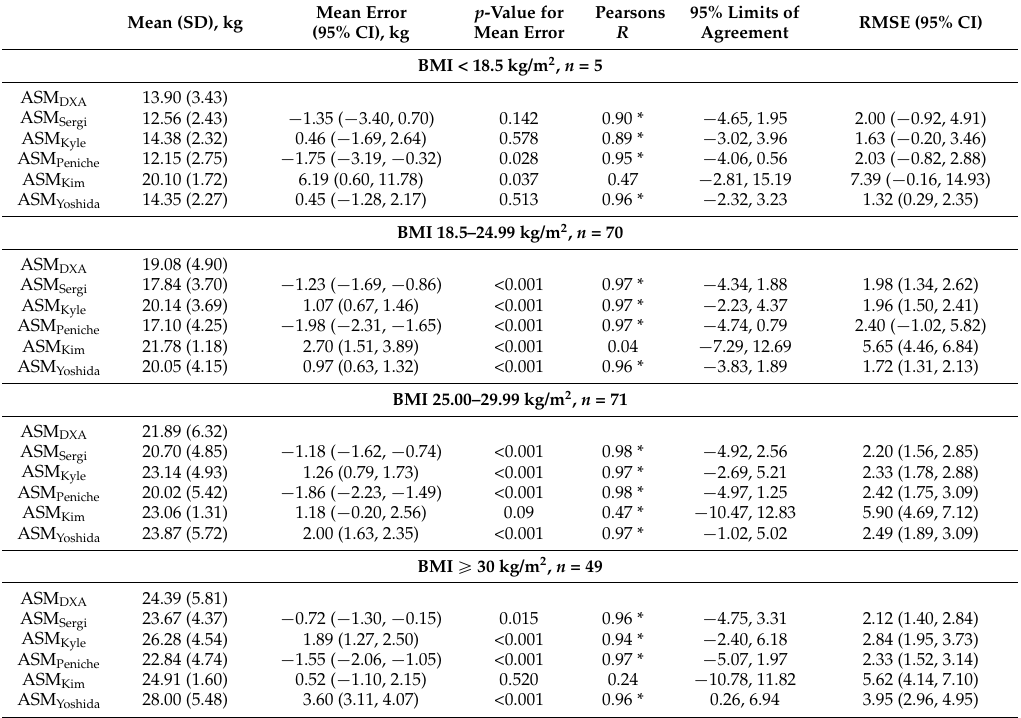
Table 4. Comparison of the five BIA prediction equations across different body mass index (BMI)